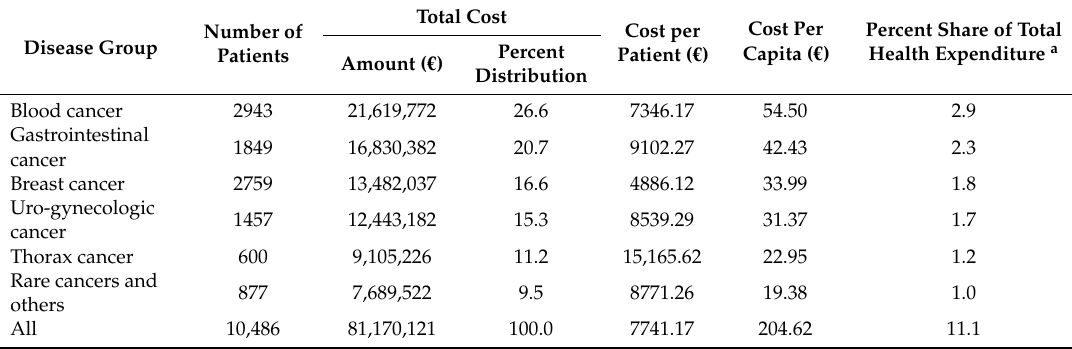
Table 1. Annual number of cancer patients, total healthcare cost, cost per patient, cost per capita, and percent share of total health expenditure per capita, by disease group (Province of Forl ì -Cesena, northern Italy, year 2016).